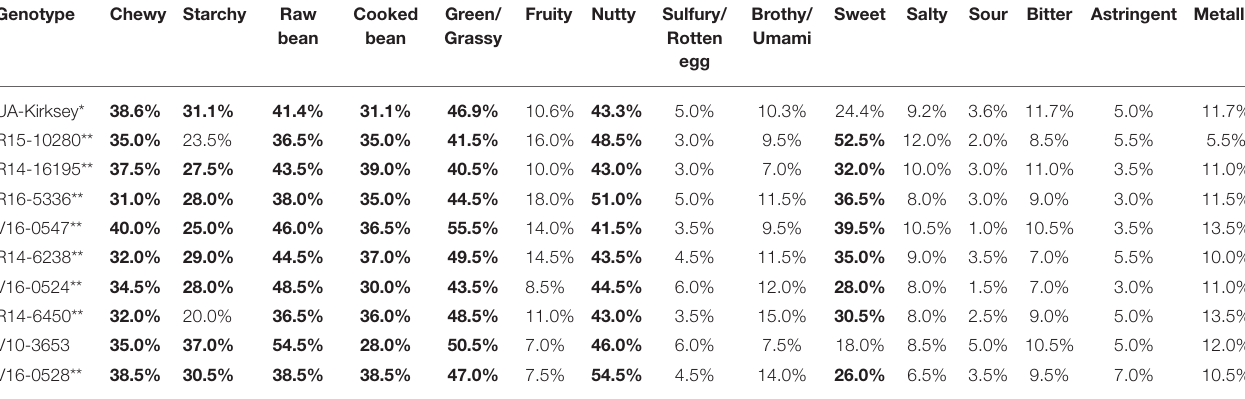
TABLE 5 | Validation study: sensory scores (overall acceptability, sweetness intensity, aroma, appearance, taste, and texture) of edamame genotypes for breeding selection. Genotype